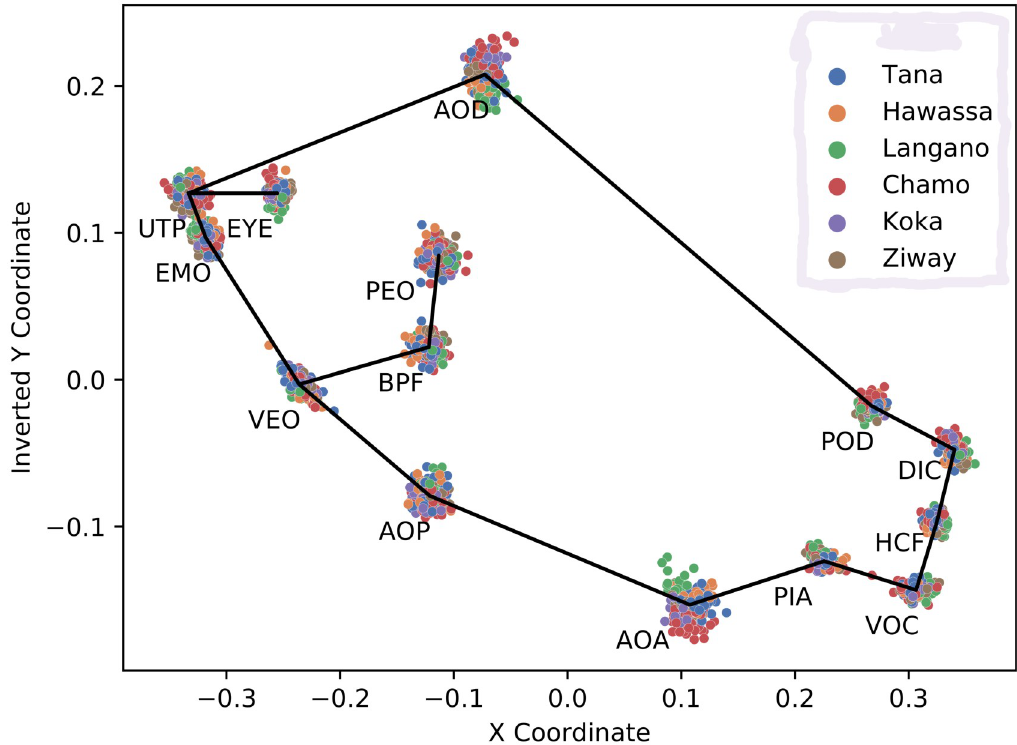
Fig 4. Scatter plot of GPA transformed landmark positions. The coordinates of the landmarks listed in Table 2 are processed with a generalized Procrustes analysis. After color coding by lake, the 14 two dimensional landmark coordinates of all Nile tilapia samples are visualized as dots. The solid line connects the center locations of all